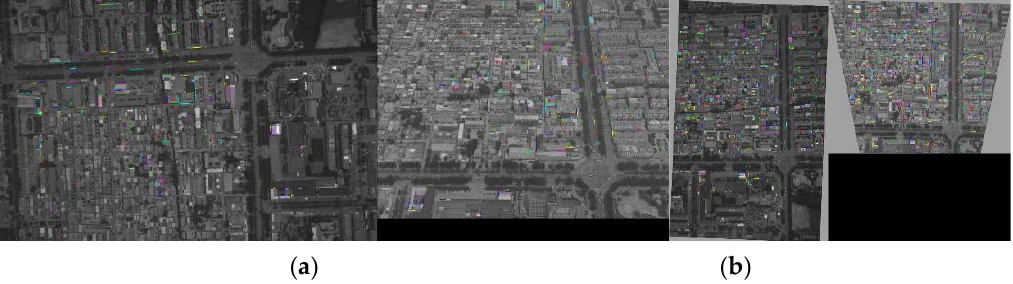
Figure 11. Comparison of the line matching results of the second image pair between original images and rectified images: ( a ) original images, 130/166/78.3%; ( b ) rectified images, 520/558/93.2%.